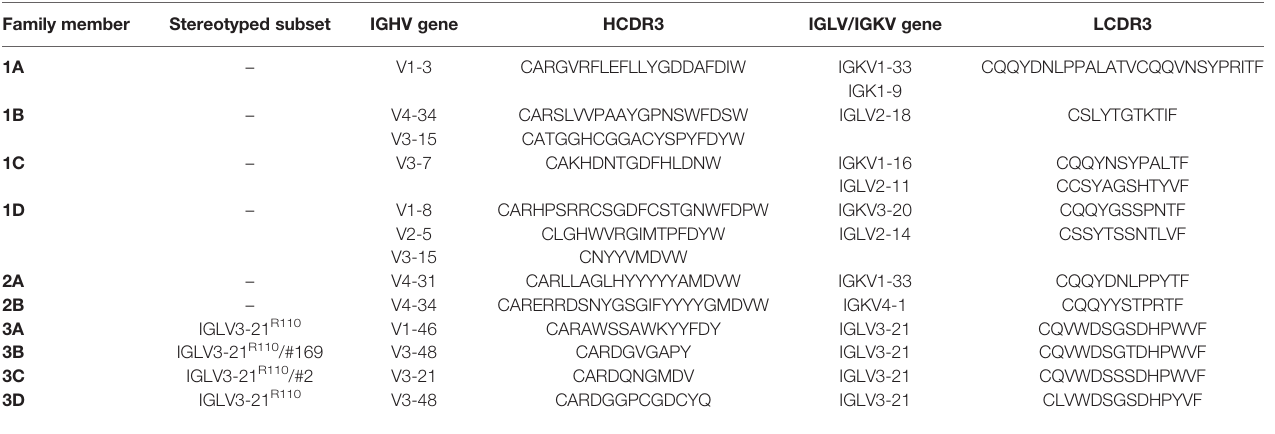
TABLE 1 | Overview of BcR IG sequencing